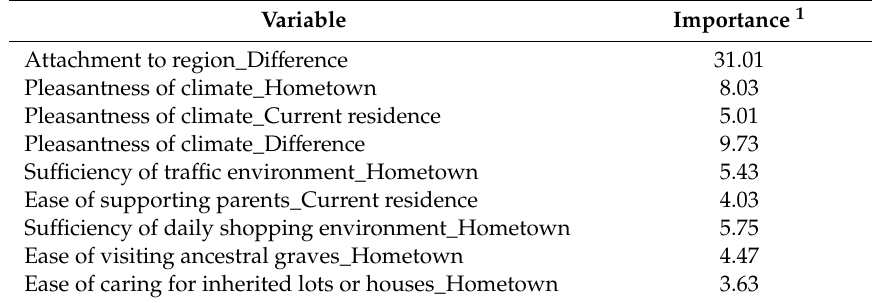
Table A1. The value of importance of each variable adopted in the decision